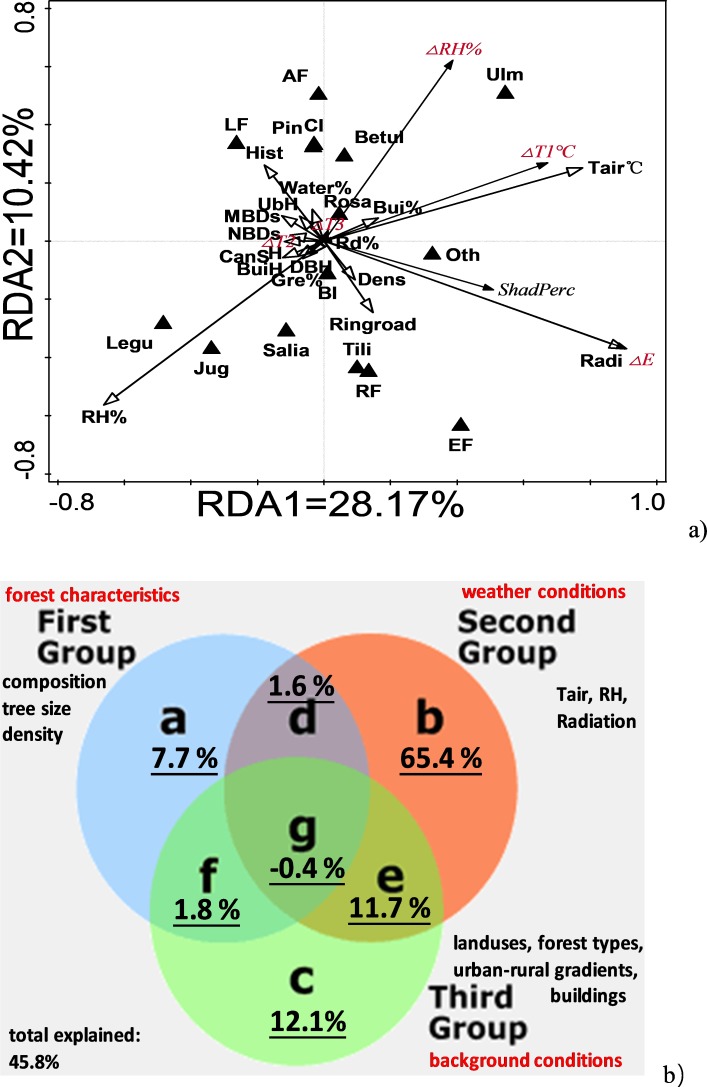
Redundancy ordination between microclimate regulation functions, background conditions, forest characteristics and weather conditions.(A) Ordination results and (B) RDA-related variation partitioning between background conditions, weather conditions and forest characteristics. Abbreviations used in figure: microclimate regulation functions: ΔT1, ΔT2, ΔT3, ΔE, shading (%) and ΔRH. Background conditions: distance to nearest building (NBDs); height of nearest building (BuiH), mean distance to buildings (MBDs); road percentage, (Rd%); green space percentage (Gre%); build percentage (Bui%); water percentage (water%); forest types (AF, LF, EF and RF); urban history (Hist); and ring road region (Ring road). Weather conditions outside forests: Tair, RH, Radiation. Forest characteristics: DBH, Tree height (H), canopy size (Can S), under branch height (UBH), tree density (Dens), broadleaf (BL), conifer leaf (CL), and forest composition percentage of the families Ulmaceae (Ulm), Pinaceae (Pin), Betulaceae (Betul), Leguminosae (Legu), Salicaceae (Salia), Juglaceae (Jug), Rosaceae (Rosa) and others (Oth).